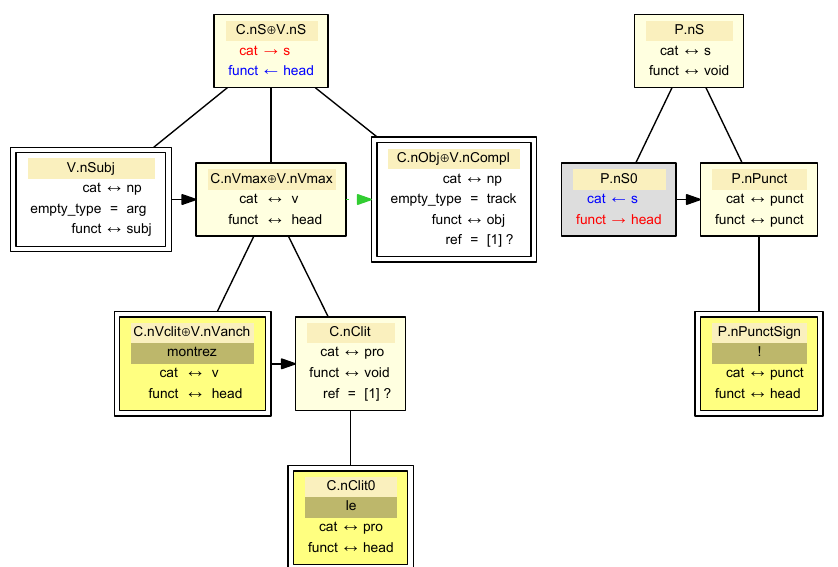
Figure 5: PTD after a second merging step in the parsing of the sentence